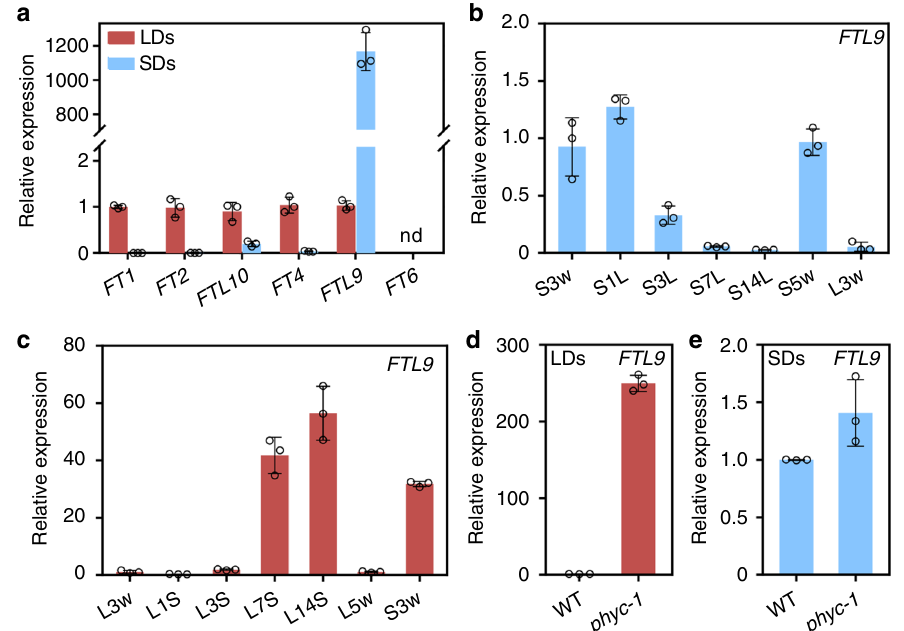
Fig. 1 FTL9 is speci fi cally induced under SDs in B. distachyon. a qRT-PCR analysis of six FT orthologous gene expressions at ZT4 under SDs and LDs. UBC18 was used as an internal control for normalization of qRT-PCR results. Plant newly expanded leaves were harvested for RNA isolation and gene expression analysis. Error bars indicate s.d. b Time course analysis of FTL9 expression at ZT4 when three-week-old SD plants were shifted to LDs for 1 day (S1L), 3 days (S3L), 7 days (S7L), and 14 days (S14L), respectively. S3w and S5w indicate that B. distachyon were grown under consistent SDs for 3 and 5 weeks. L3w indicates that B. distachyon were grown under LDs for 3 weeks as a control. UBC18 was used as an internal control for normalization of qRT-PCR results. Error bars represent s.d. c Time course analysis of FTL9 expression at ZT4 when three-week-old LD plants were shifted to SDs for 1 day (L1S), 3 days (L3S), 7 days (L7S) and 14 days (L14S), respectively. L3w and L5w indicate that B. distachyon were grown under consistent LDs for 3 and 5 weeks. S3w indicates that B. distachyon were grown under SDs for 3 weeks as a control. Error bars represent s.d. d qRT-PCR analysis of FTL9 expression under LDs in the wild-type Bd21-3 and phyc-1 homozyous mutants. UBC18 was used as an internal control for normalization of qRT-PCR results. Error bar means